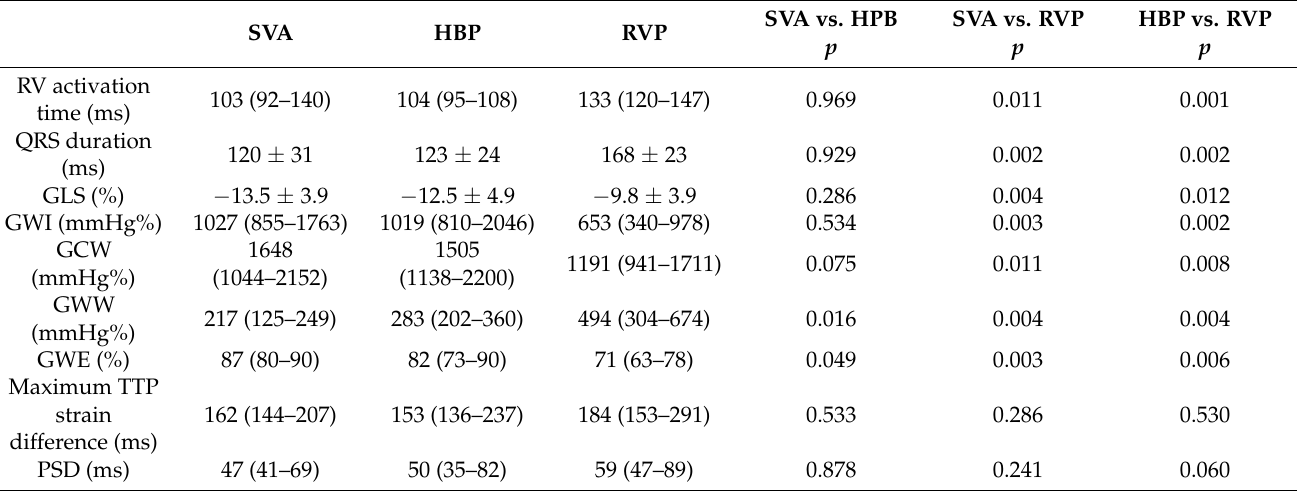
Table 3. Three-dimensional electroanatomic mapping, ECG and myocardial work.